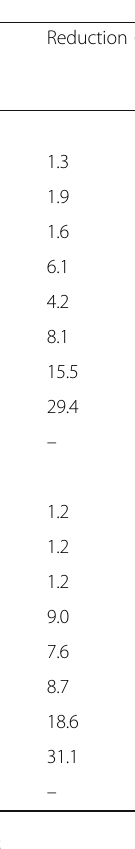
Table 4 Effects on white rot disease incidence (%) in garlic under field conditions